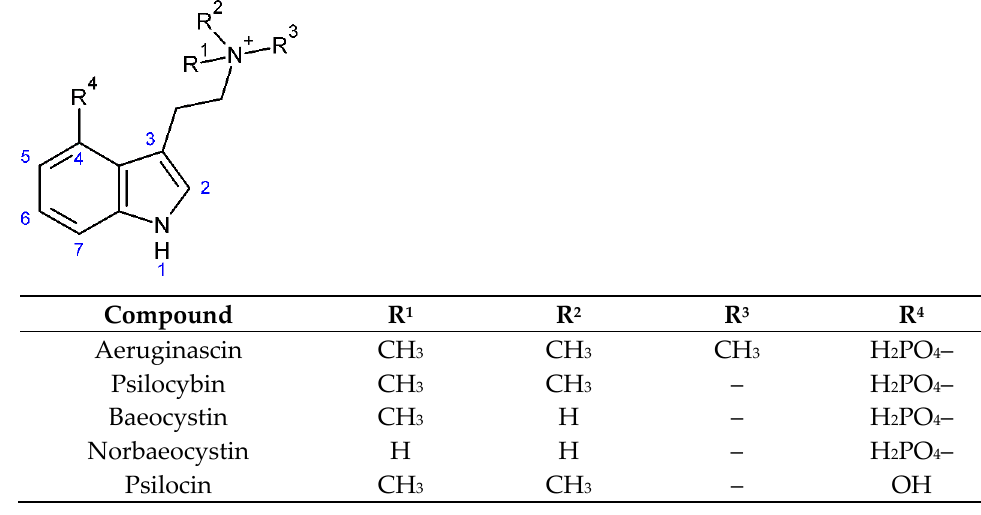
Figure 1. The structure of tryptamines quantified within this study.